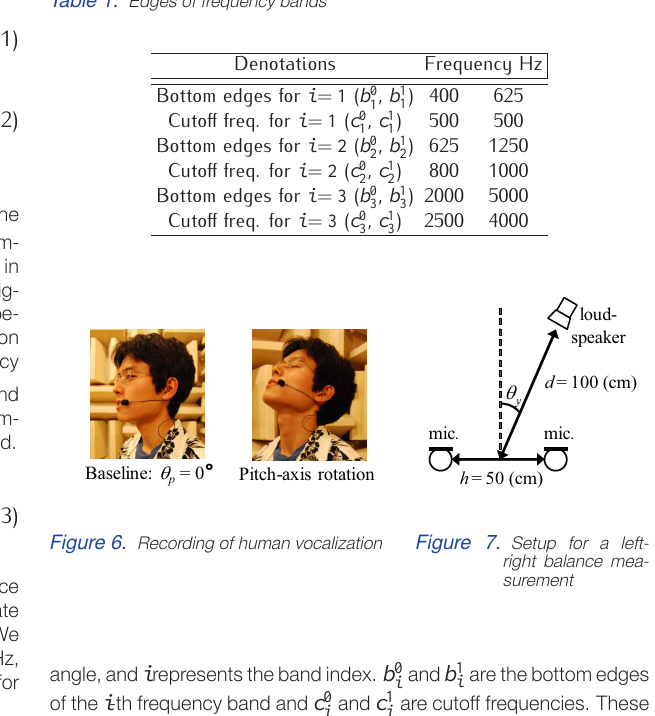
Figure 6. Recording of human vocalization Figure 7. Setup for a left- angle, and i represents the band index. b 0 i and b 1 i are the bottom